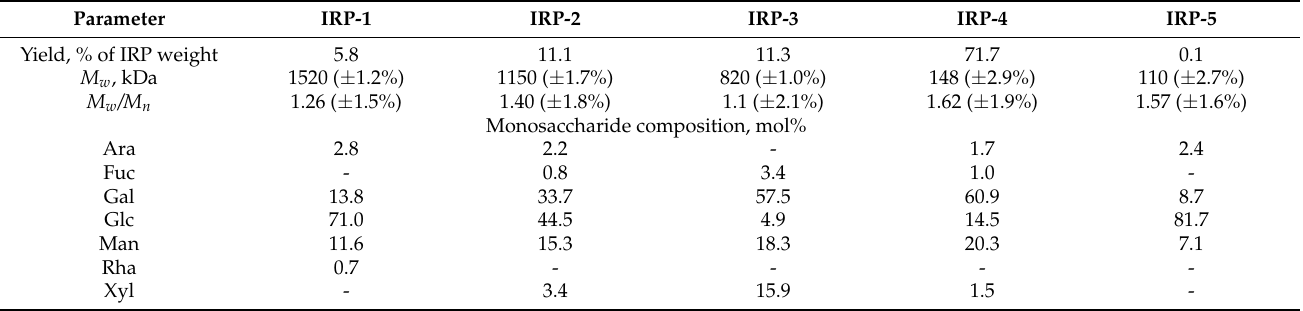
Figure 3. Elution curve of IRP fractions on the Sephacryl 400HR ( a ) and HPLC-UV chromatograms of PMP-labeled monosaccharides in IRP fraction hydrolysates ( b ). IRP fractions: 1 —IRP-1, 2 —IRP-2, 3 —IRP-3, 4 —IRP-4, 5 —IRP-5. Table 2. Yield, molecular weight, and monosaccharide composition of IRP fractions after Sephacryl 400HR